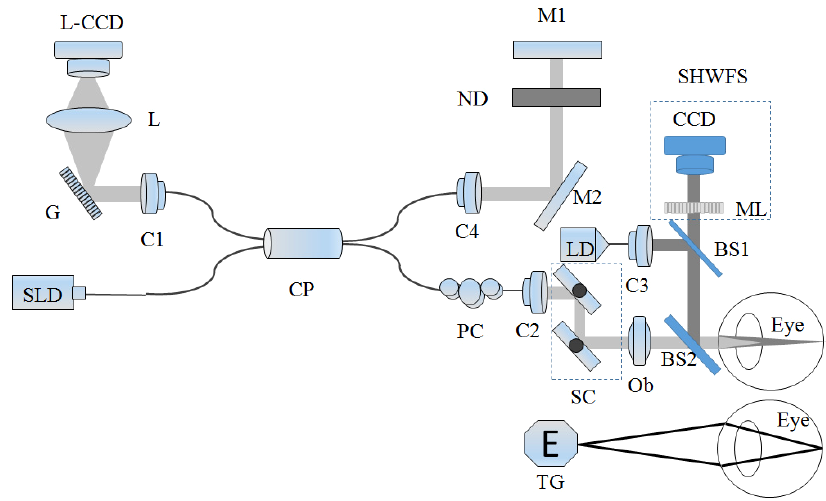
Fig. 1. Diagram of the integrated UL-OCT and SHWFS; SLD: super luminescent diode; CP: ¯ber coupler; C1 (cid:2) C4: ¯ber colli- mator; G: grating; L-CCD: line scan charge-coupled device; L: lens; ND: neutral density ¯lter; M1, M2: mirror; PC: polarization controller; SC: X-Y scanner; Ob: objective; BS1, BS2: beam splitter; LD: laser diode; ML: micro-lens array; CCD:CCD camera; SHWFS: Shack – Hartmann wavefront sensor; TG: